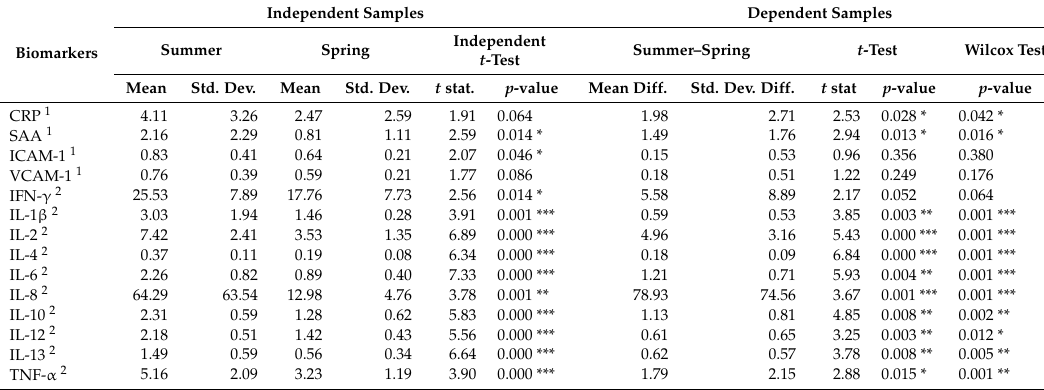
Table 2. Comparisons of biomarker concentrations for traffic volunteers in Kathmandu between spring and summer, 2014.